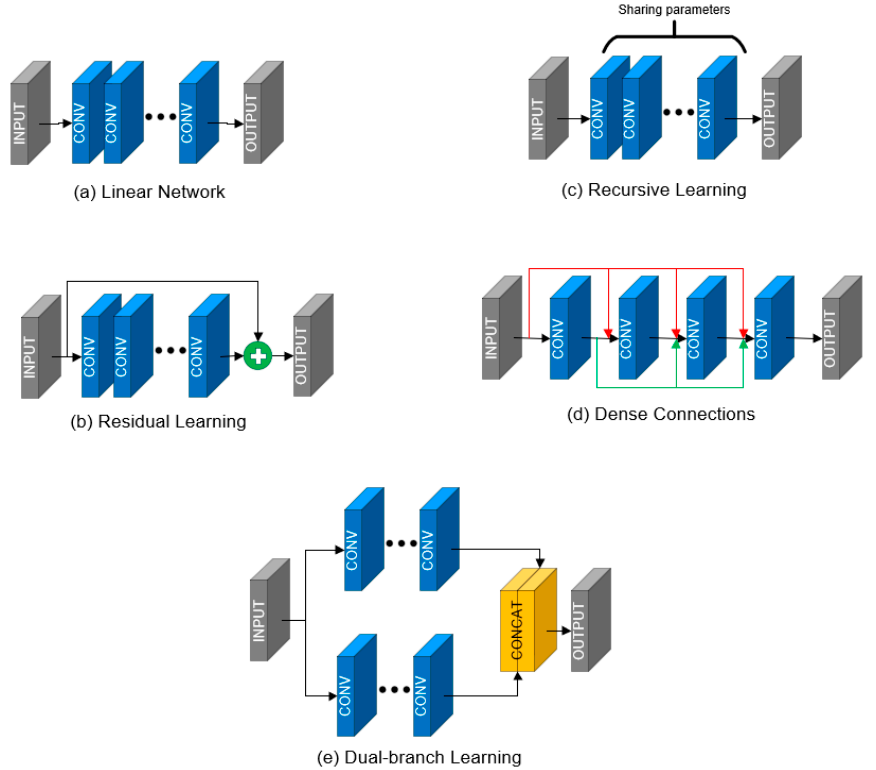
Figure 21. Network design strategies: ( a ) Linear network; ( b ) Residual learning; ( c ) Recursive learning; ( d ) Dense connections; ( e ) Dual-branch learning